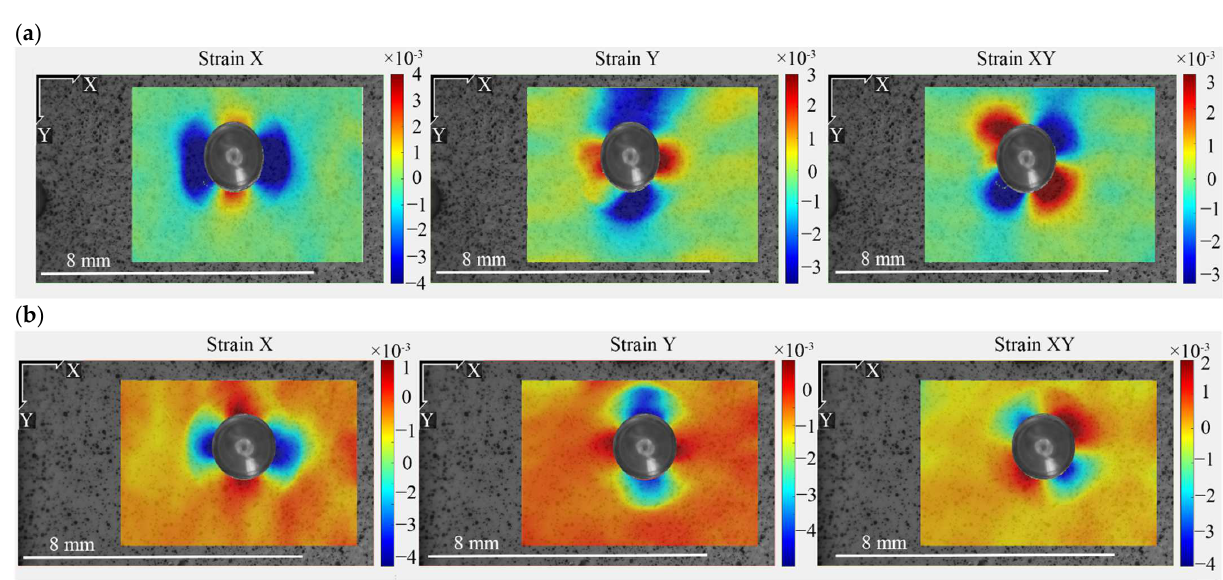
Figure A2. Strains X and Y at point C ( a ) and point T ( b ) induced during hole drilling.